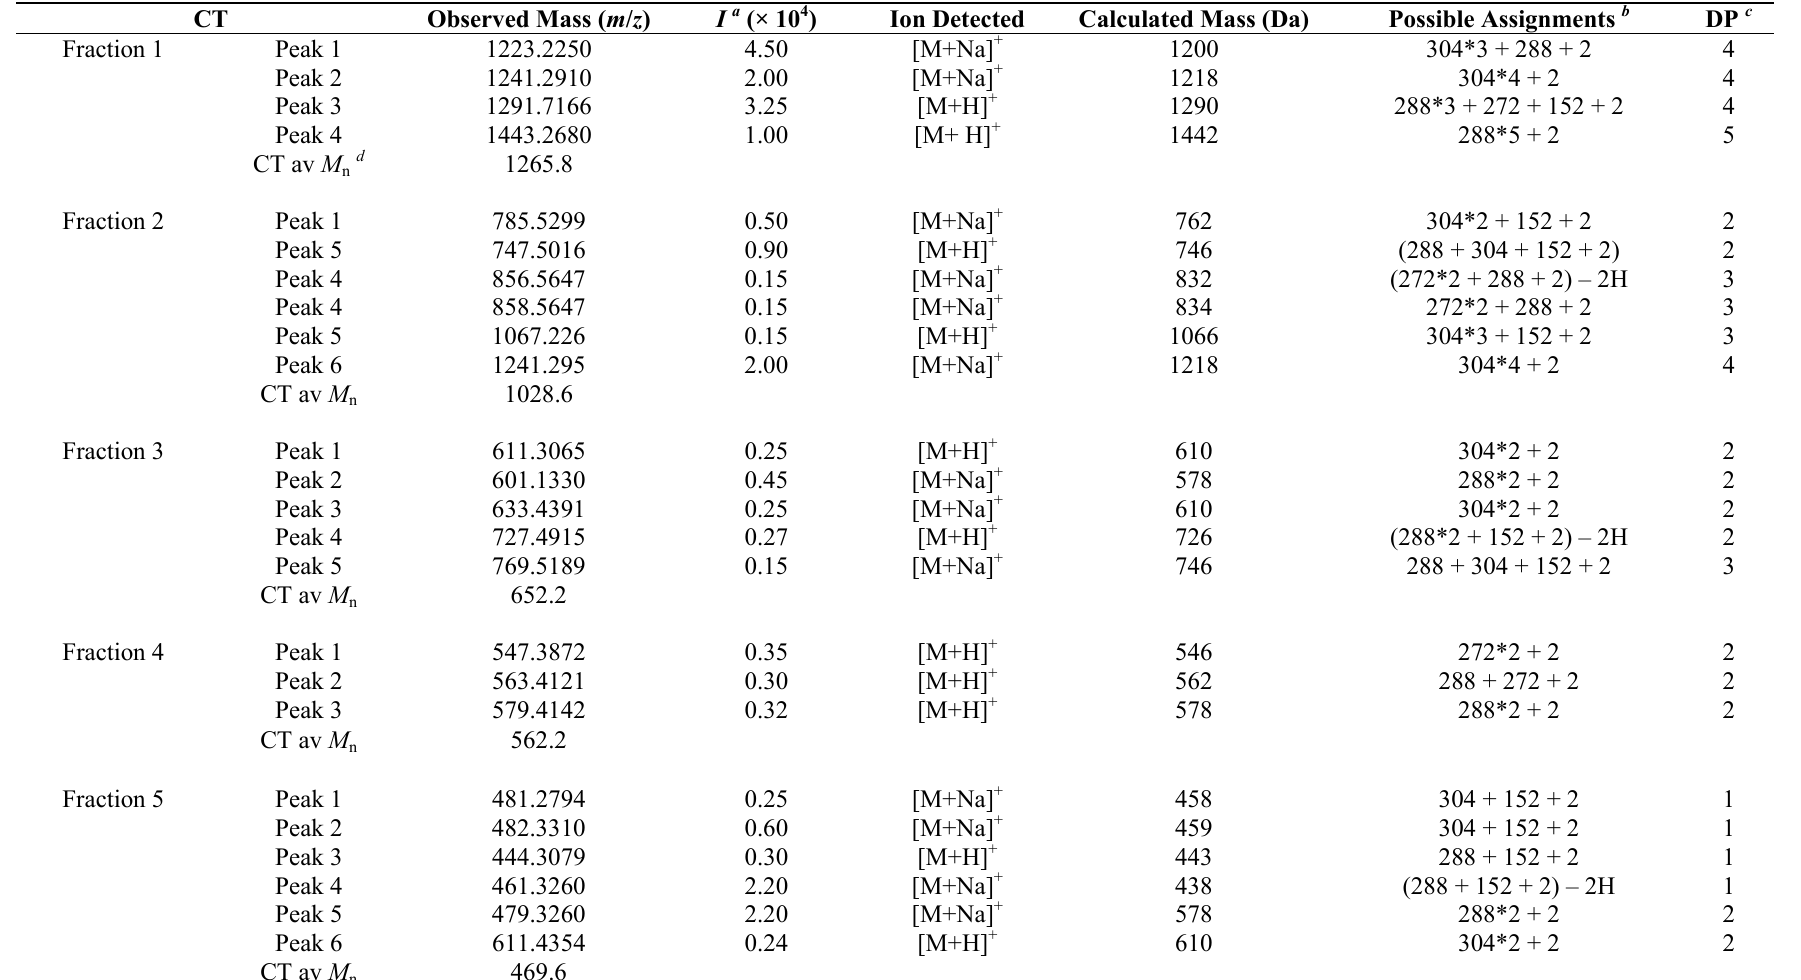
Table 4. Composition of the five fractions of CTs identified by Q-TOF LC-MS